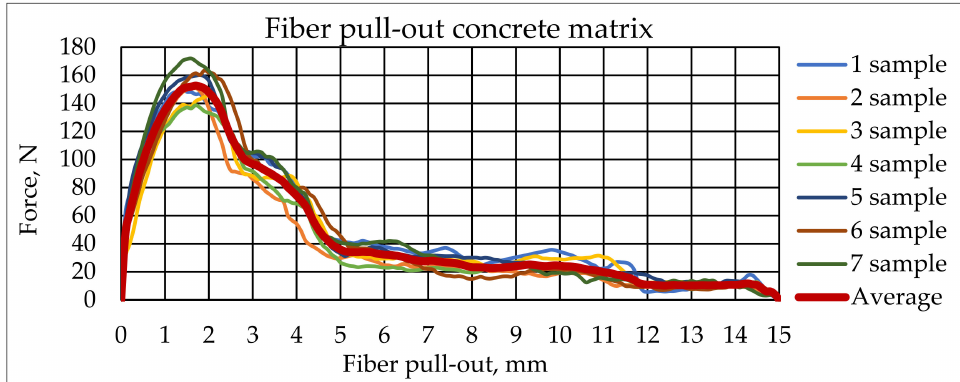
Figure 14. Fiber pull-out from the concrete